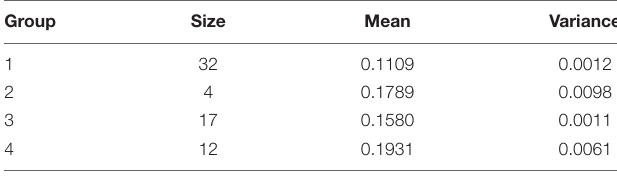
TABLE 3 | BSI analysis summary statistic.